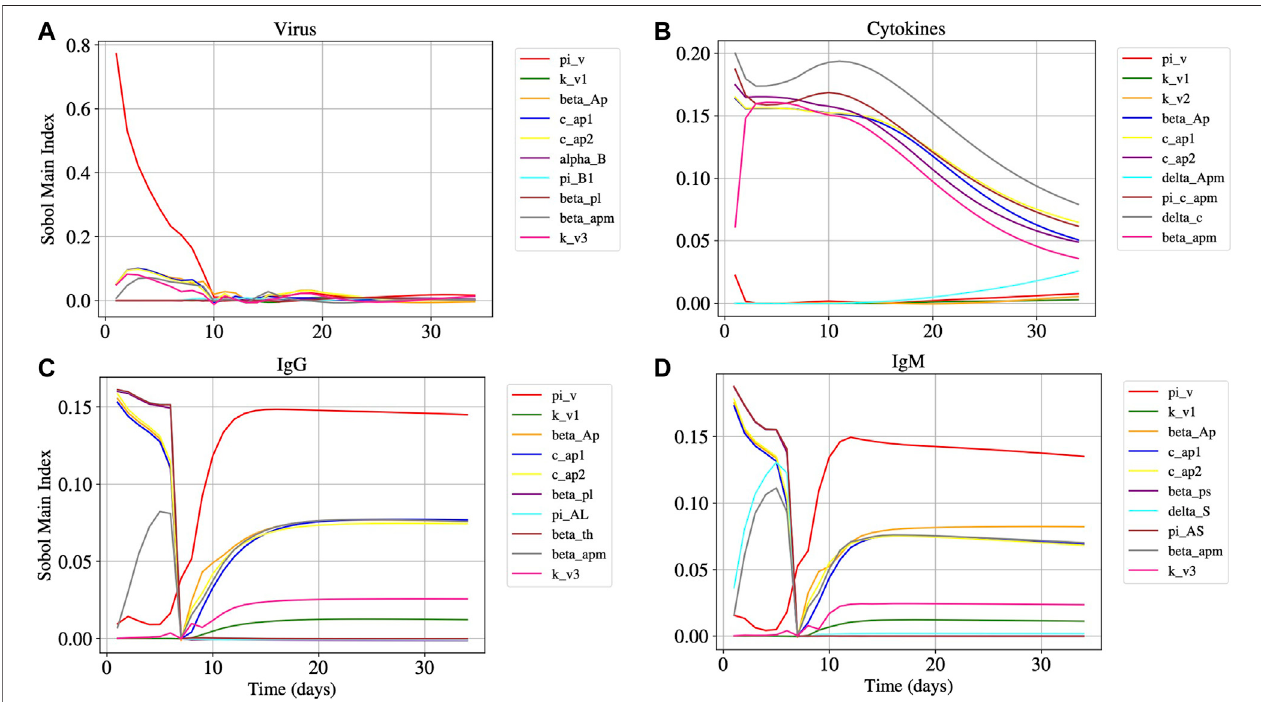
FIGURE 5 | Panels A, B, C, and D represents the Sobol main index over time of Eqs 1 , 15 , 14 and 13 , respectively. The main Sobol indexes were evaluated for all model parameters, but Panels A, B, C, and D presents the 10 parameters with largest in fl uence in the